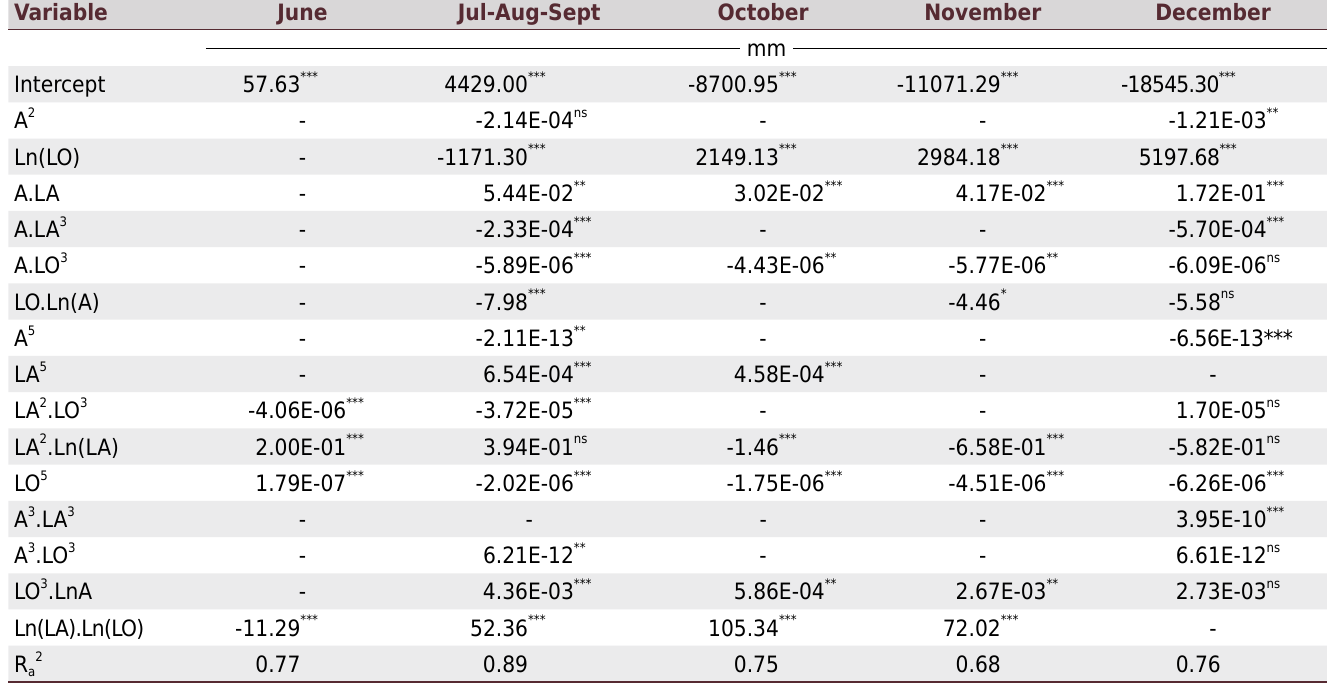
Table 3. Fitted statistical models for rainfall (June, July-September, October, November, and December)